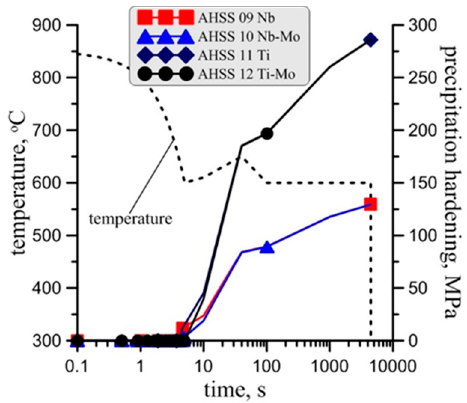
Figure 20. Contribution of precipitates to the increase in the yield stress of the AHSS grades calculated using Equation (7) for cooling schedules characteristic for the hot strip mill.